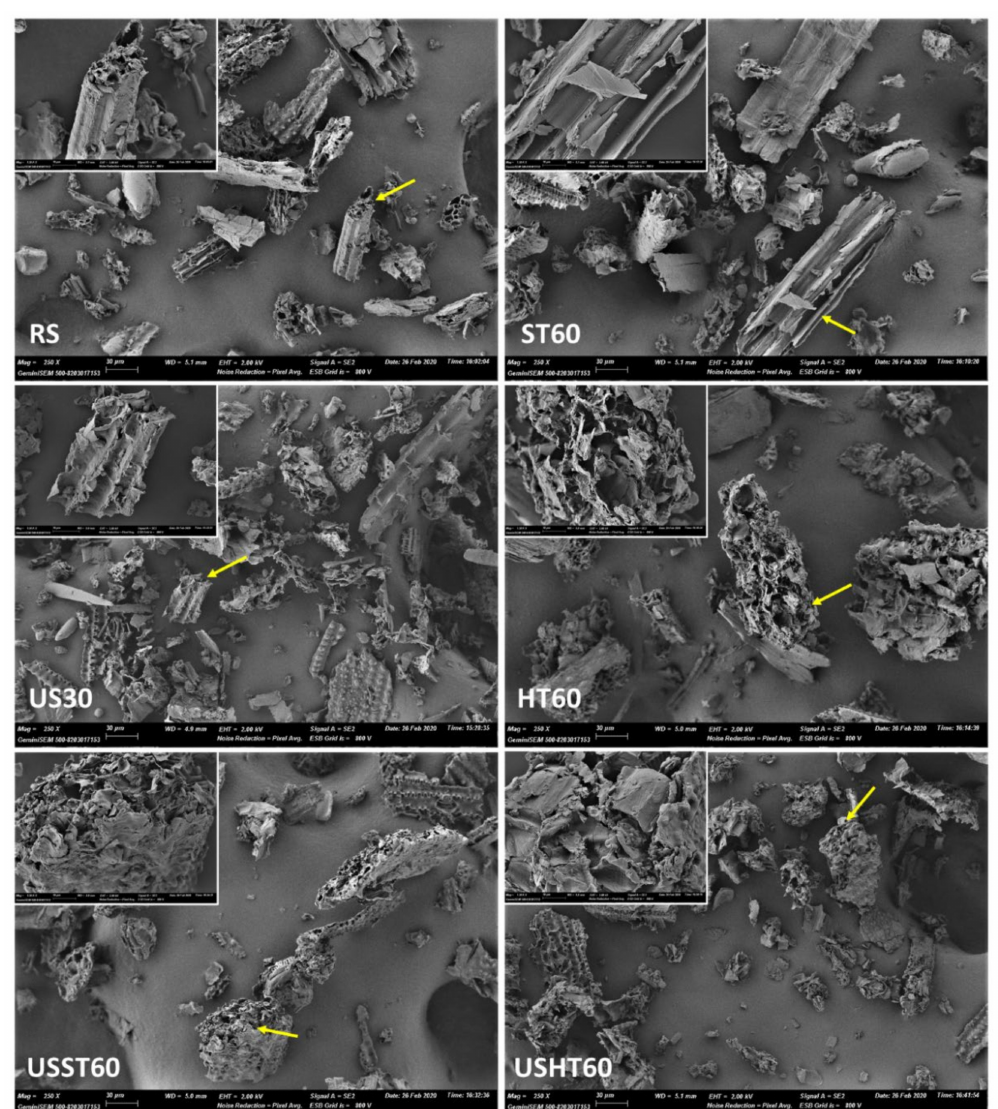
Figure 4. High-resolution field emission scanning electron microscopy (FESEM) images of the particles from the residual powder and untreated RS (1300 × magnification). (RS: rice straw, US: ultrasound, ST: stirring, HT: heating at reflux, USST, and USHT: combined treatments). The number in the sample code indicates the processing time. Micrographs of di ff erent particles (arrow marked) at higher magnification ( × 1300) were also included in each